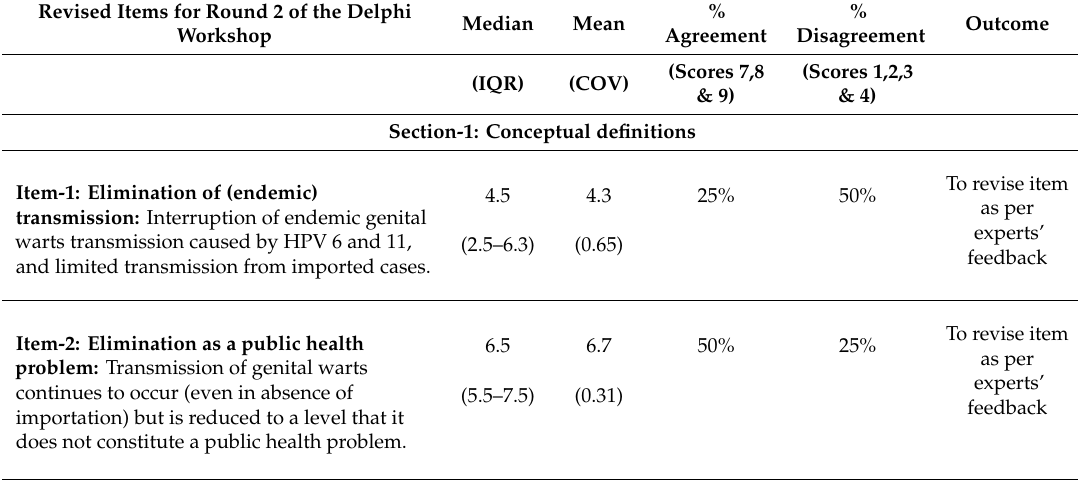
Table 3. Questionnaire and results of round 2 of the Delphi face-to-face